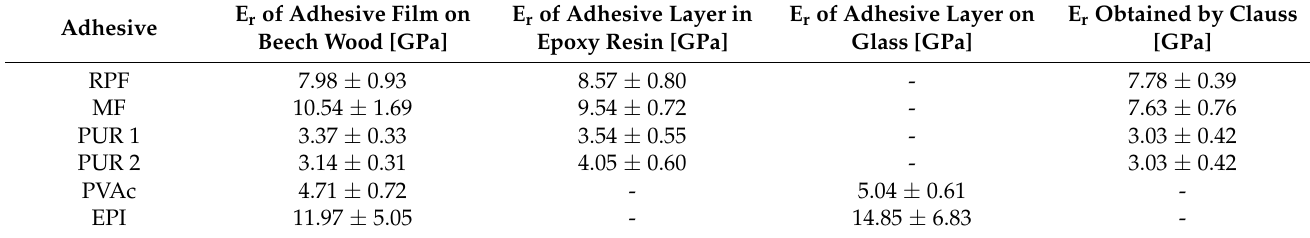
Table 7. Elastic modulus measured by means of nanoindentation (E r ) at 20 ◦ C, of the adhesive films and